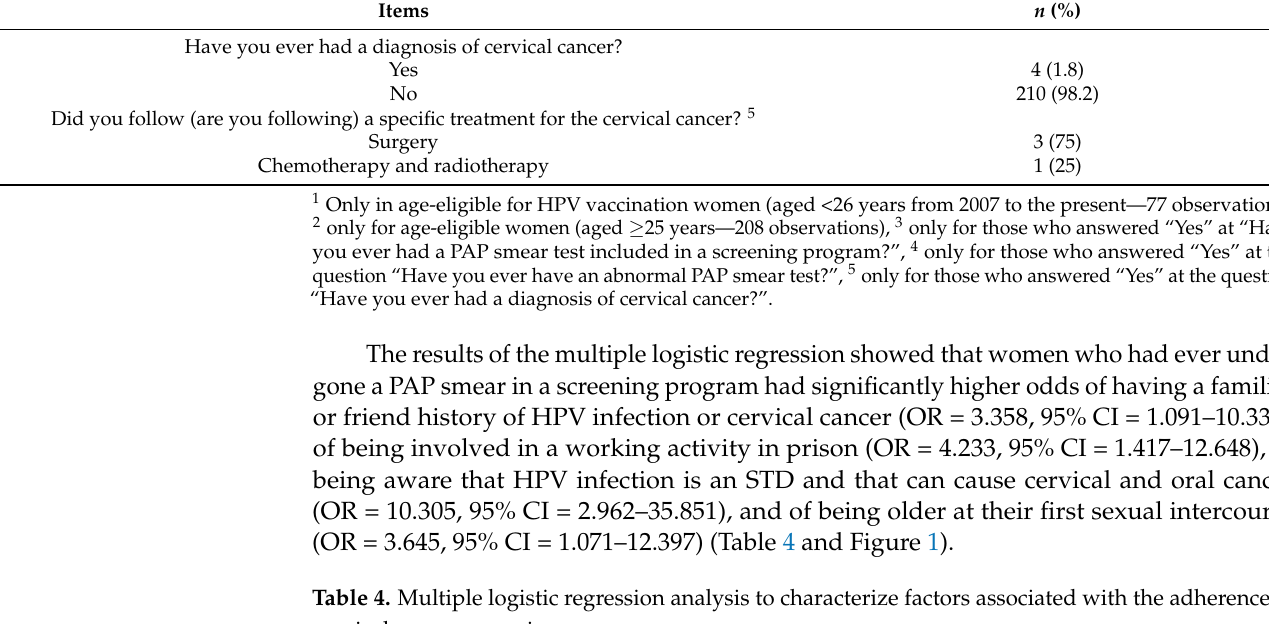
Table 4. Multiple logistic regression analysis to characterize factors associated with the adherence to cervical cancer screening